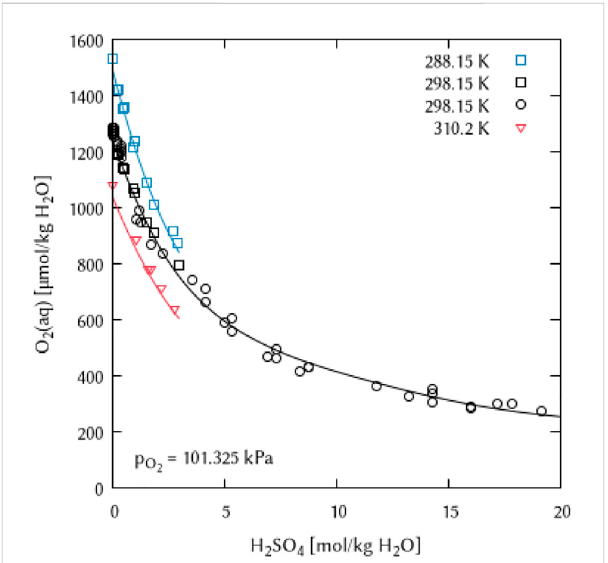
FIGURE 16 Modelling of the O 2 solubility in sulfuric acid solution as a function of temperature and H 2 SO 4 concentration. (Points: Experimental data from □ Geffcken (1904), ○ Das (2005) and ▽ Lang and Zander (1986), Lines: this